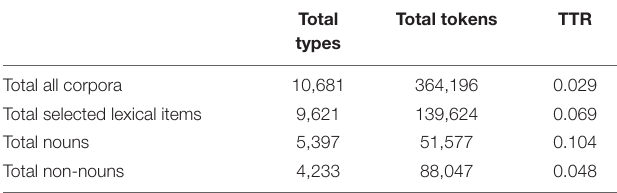
TABLE 2 | Characteristics of the groups of lexical items from all the